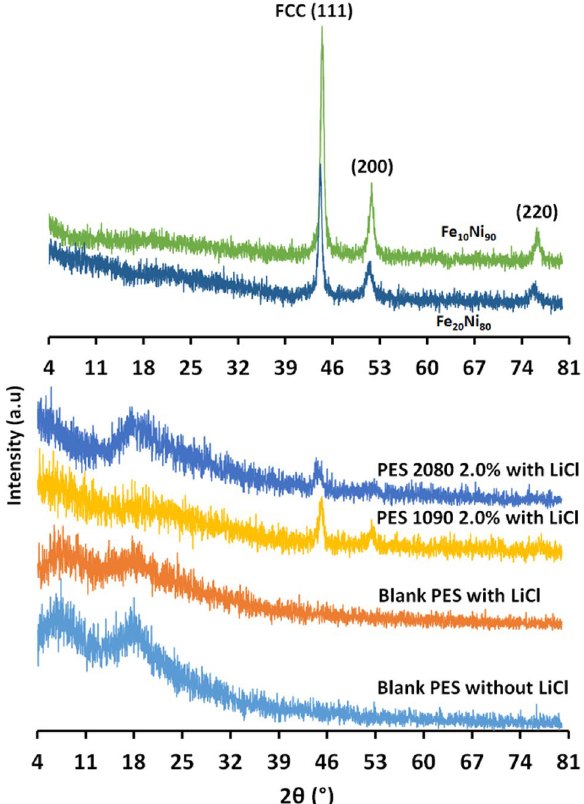
Figure 10. XRD analysis of the used magnetic iron–nickel alloys as filler, the blank PES without and with adding 0.1 wt% of Lithium chloride in the membrane dope, and the magnetic mixed matrix PES membranes in case of using 0.1 wt% of Lithium chloride in the membrane dope; PES 1090 2.0% W and PES 2080 2.0% W.